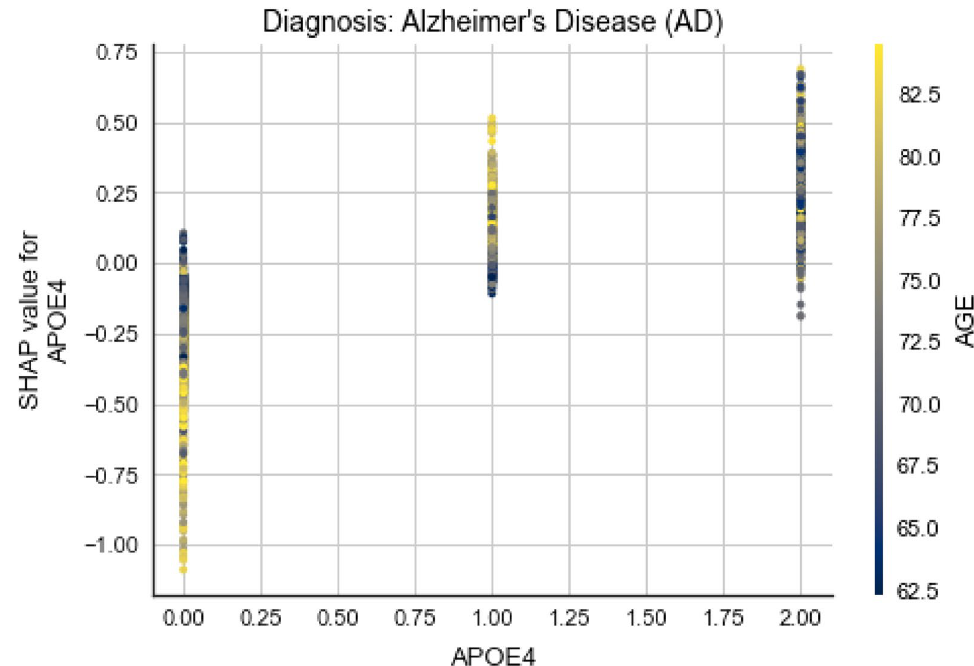
Figure 16. Dependence plot between APOE4 and AGE for AD class.